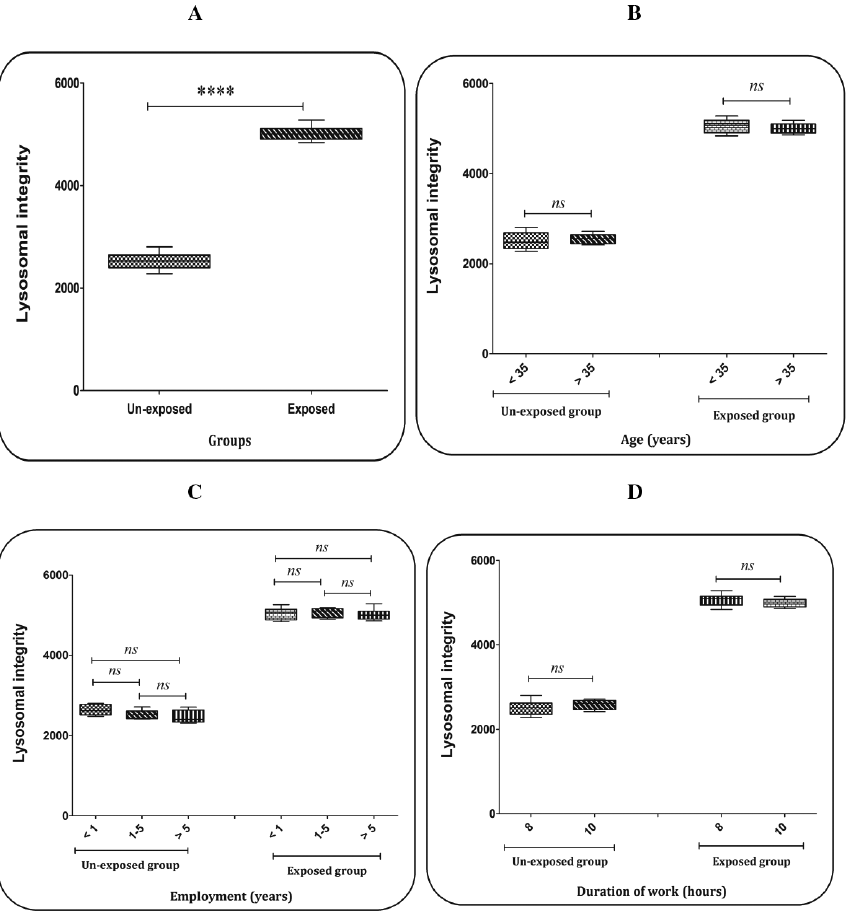
Figure 6: Lysosomal damage assay. (a) Comparison between exposure and non-exposure groups. (b) Comparison between the exposed and unexposed groups based on age (year). (c) Comparison between the exposed and unexposed groups based on employment (year). (d) Comparison between the exposed and unexposed groups based on duration of work (hours). Data are presented as mean ± SD (n = 20). **** P < 0.0001. The unit of measurement of lysosomal damage is based on fluorescent